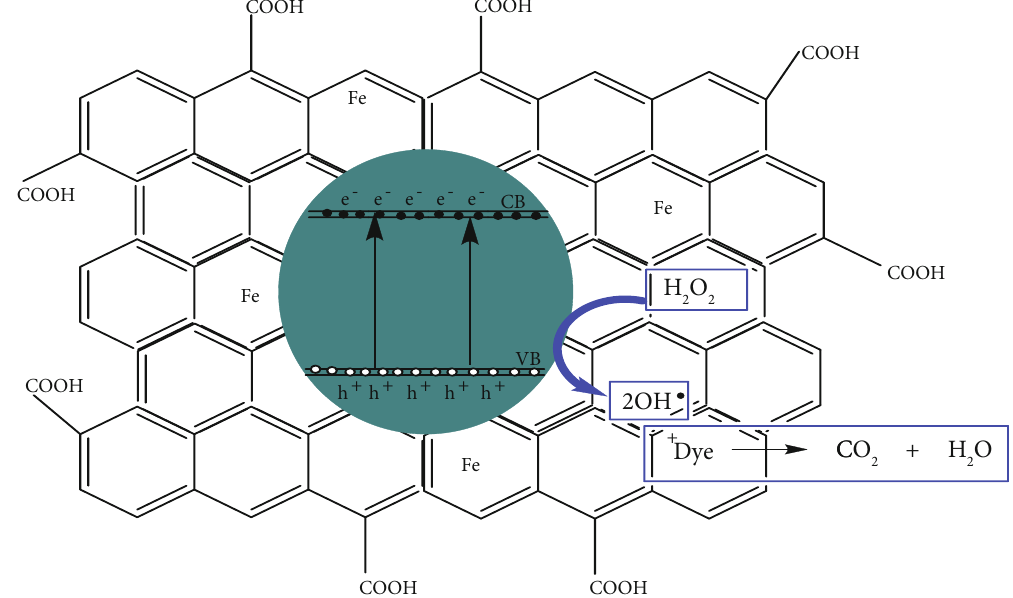
Figure 10: Plausible mechanism for degradation of dye by heterogeneous Fenton